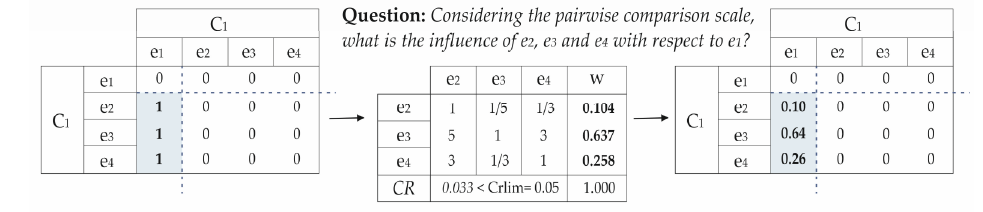
Figure 1. Example of determination of the influence between elements.